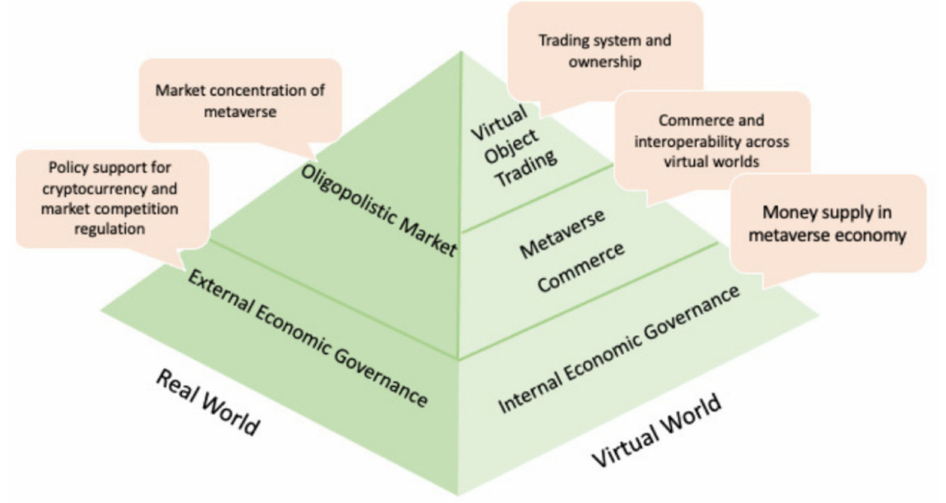
Figure 1. The industry’s market structure of the Metaverse. Source: Lee et al.